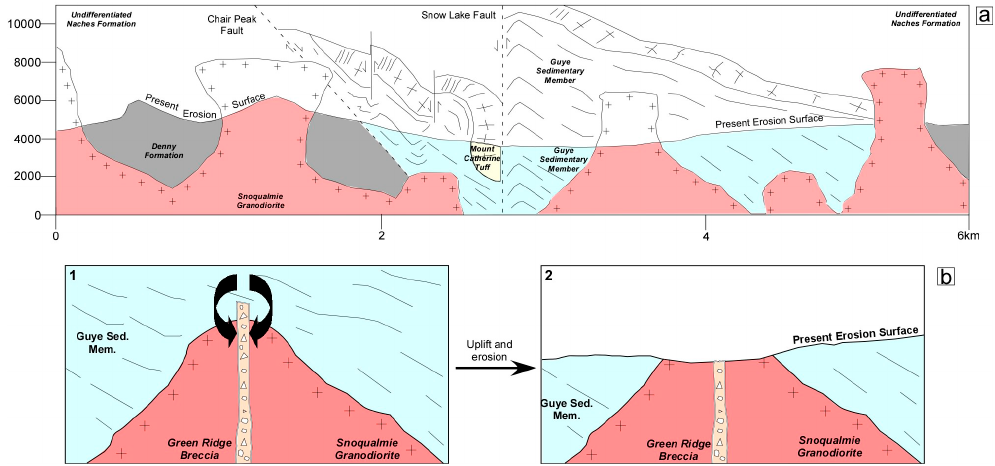
Figure 9. ( a ) An East–West cross section from an area to the south of the studied area (adapted from Chitwood, 1976) showing the emplacement of the Snoqualmie Granite into the Guye Sedimentary Member; ( b ) Schematics (1 and 2) showing the emplacement of the Snoqualmie Granite into the Guye Sedimentary Member and the subsequent formation of the Green Ridge Breccia. Convective flow vectors mark the migration of hydrocarbon bearing fluids into the Green Ridge Breccia (1). This is followed by uplift and erosion to expose the roof of the batholith and the breccia (2).